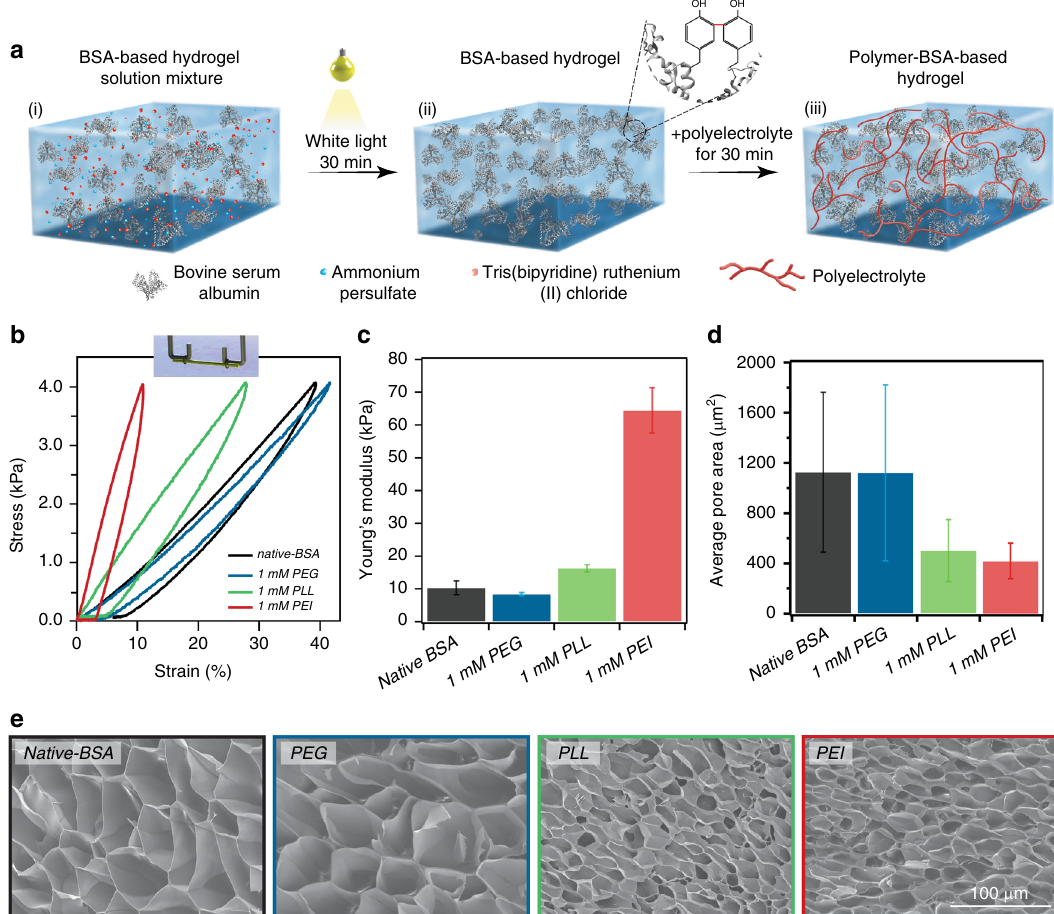
Fig. 1 Synthesis of protein-based hydrogels treated with polyelectrolytes. a Strengthening process of BSA-based hydrogel using polymer – protein interaction: (i) BSA, ammonium persulfate (APS), and Tris(bipyridine) ruthenium (II) chloride ([(Ru(bpy) 3 ] 2 + ) are mixed together; (ii) the hydrogel mixture is exposed to white light for 30 min at room temperature (RT), which leads to covalent crosslinking between BSA domains via adjacent exposed tyrosines amino acids (inset); afterwards, the hydrogel is extruded into the TRIS solution; (iii) the hydrogel is treated with one of three polymer solutions for 30 min: PEI, PLL, or PEG, all dissolved in TRIS buffer. Thereafter, the hydrogel is moved back to TRIS solution, to remove any unbounded polymer molecules. b Stress – strain curves of native-BSA (black) and after incubation with 1 mM PEG (blue), PLL (green), and PEI (red). Inset: Scheme of the tethered hydrogels to the force-clamp (FC) rheometer hooks. c Average Young ’ s moduli calculated from stress – strain curves of native- BSA, and when treated 1 mM of PEG (blue), PLL (green), and PEI (red). d Average pore-size values of native-BSA (black), and after incubation with 1 mM PEG (blue), PLL (green), and PEI (red) samples, as derived from SEM images analysis. e SEM images of native-BSA, and after incubation with the same polyelectrolytes. All error bars are SD from n = 3 independent